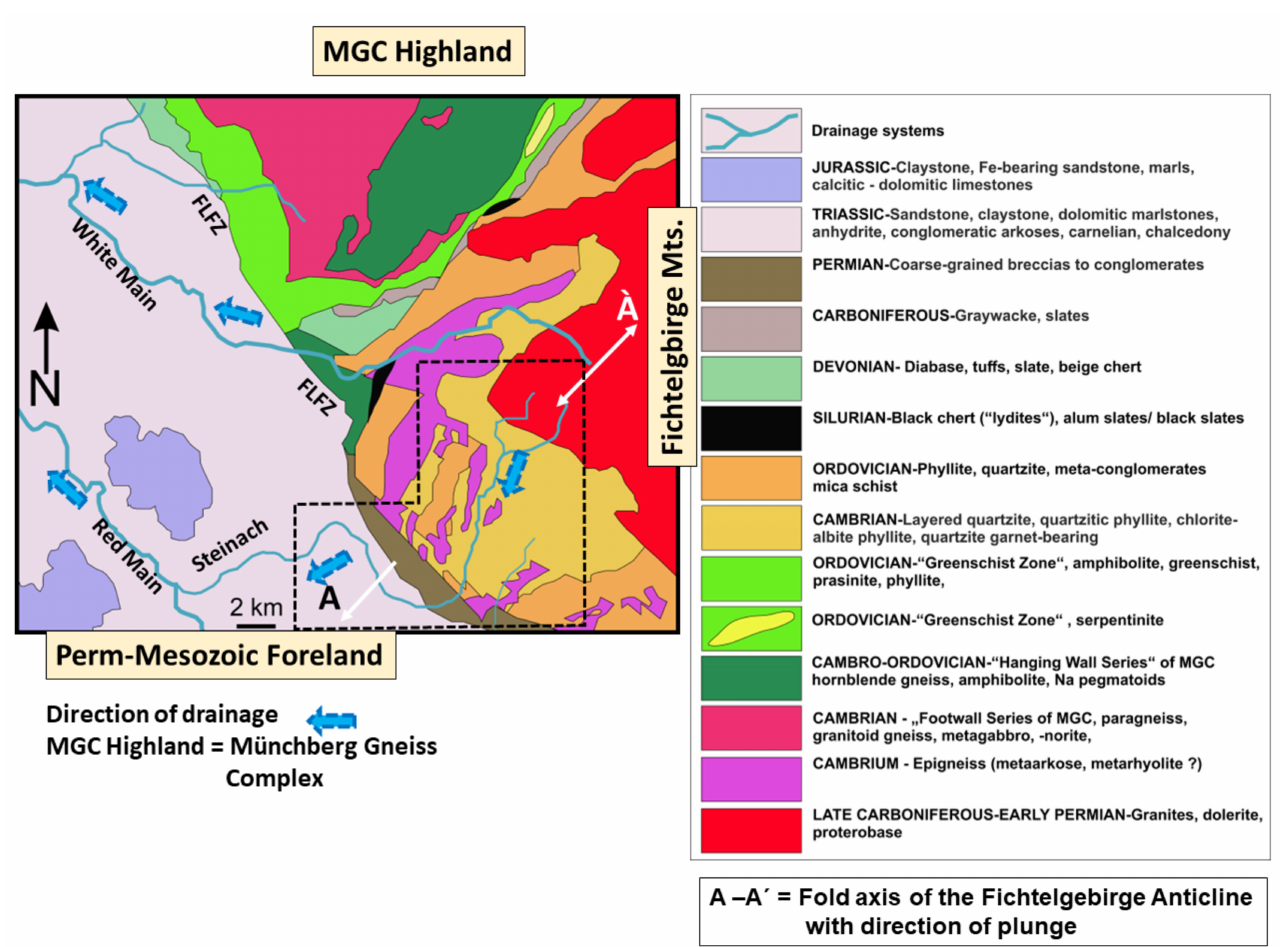
Figure 2. The position of the GMS study area and the geological setting of the NE-Bavarian Basement with its Permo-Mesozoic foreland. The geological setting of the study area sensu lato , the hydrography and the position of Steinach drainage area (study area sensu stricto ) at the basement-foreland boundary, are highlighted by the stippled line and they are on display in Figure 3. FLFZ: Franconian Line fault